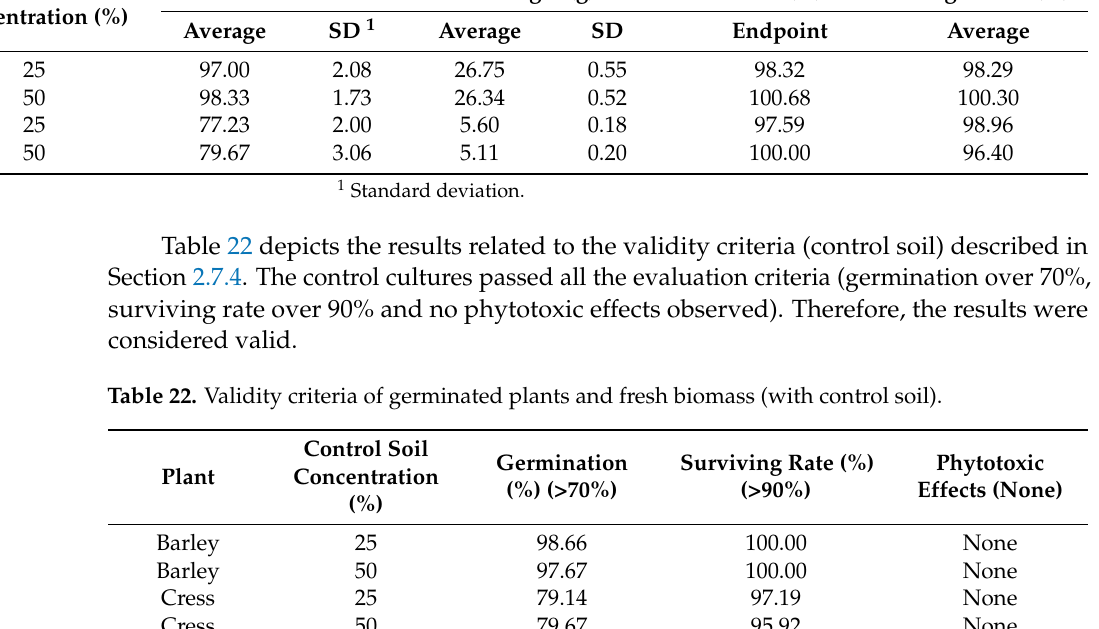
Table 22. Validity criteria of germinated plants and fresh biomass (with control soil).